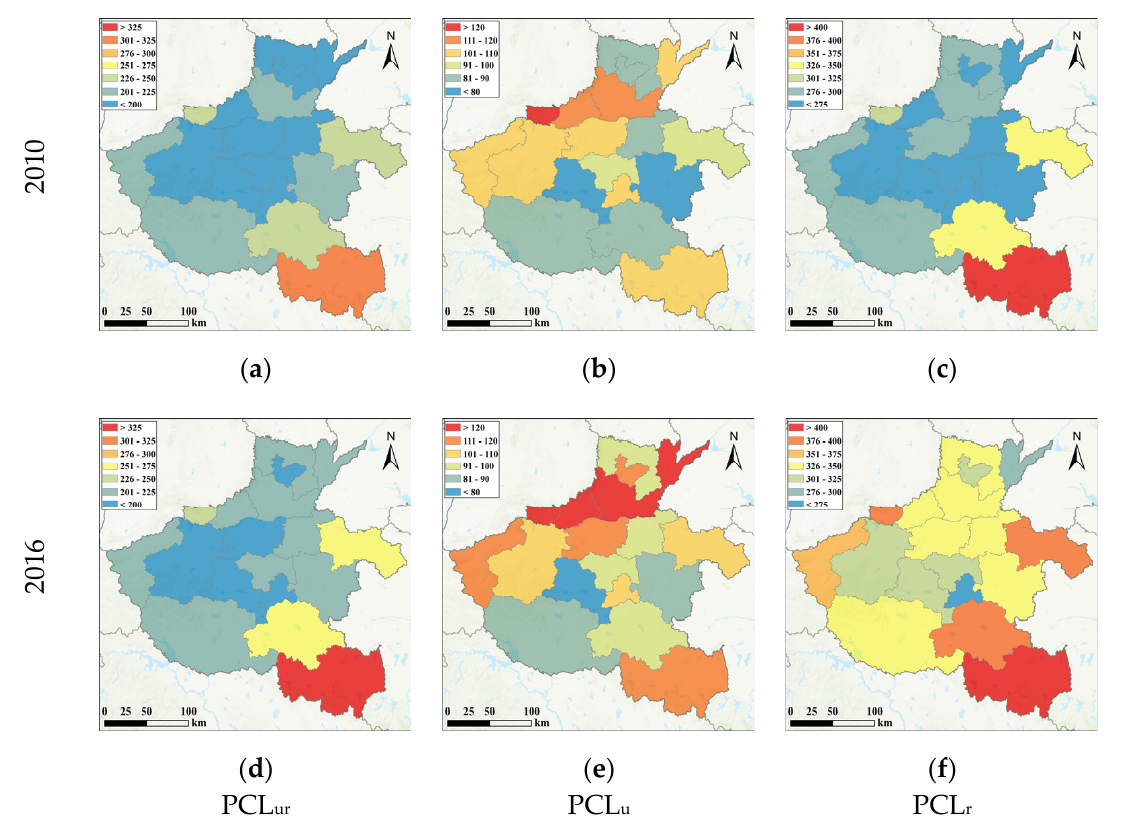
Figure 6. Regional PCL changes of URCL in Henan province from 2010 to 2016 (Unit: m 2 /person): ( a ) regional PCL of URCL in 2010; ( b ) regional PCL of UCL in 2010; ( c ) regional PCL of RCL in 2010; ( d ) regional PCL of URCL in 2016; ( e ) regional PCL of UCL in 2016; ( f ) regional PCL of RCL in 2016.